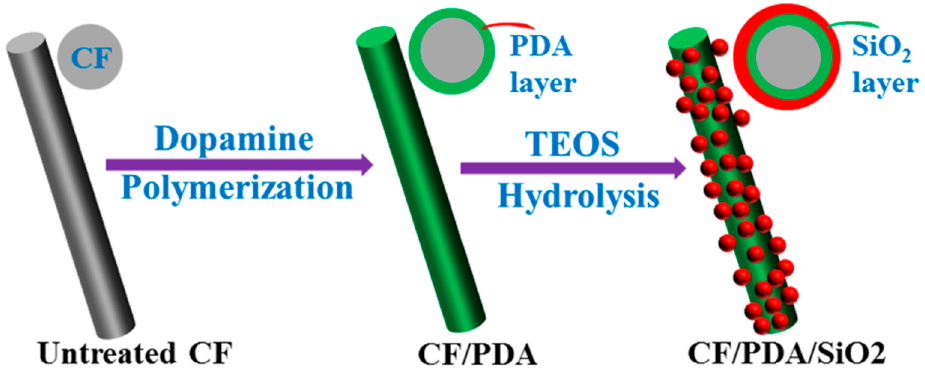
Figure 1. Schematic of binding SiO 2 coating onto the modified fiber surface via self-polymerized polydopamine.